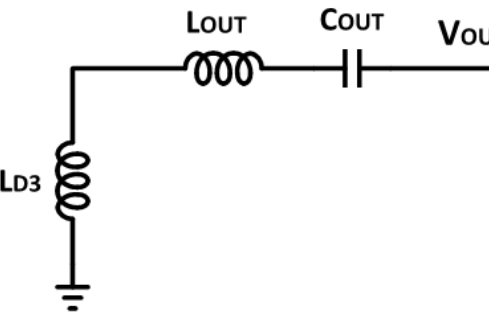
Figure 7. Output impedance equivalent circuit.